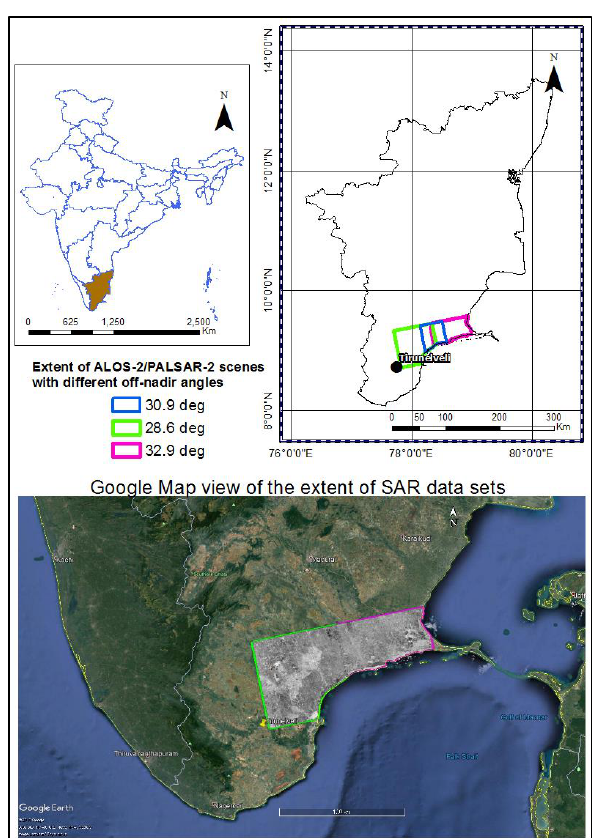
Figure 2. Position of ALOS-2/PALSAR-2 scenes are shown with respect to the ground-station at Tirunelveli. The extents of scenes with different off-nadir angle are also shown.